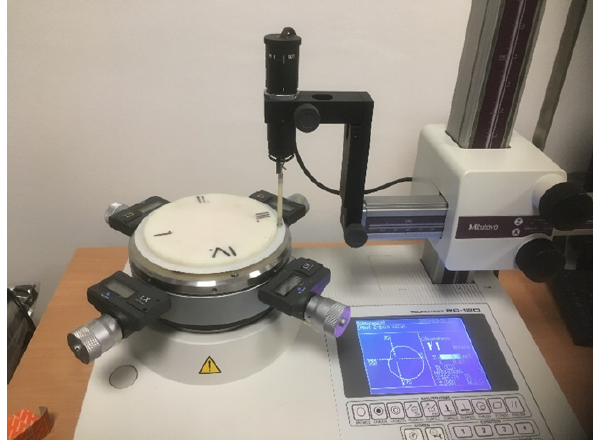
Figure 14: Measuring of the roundness by device Roundtest RA 120.